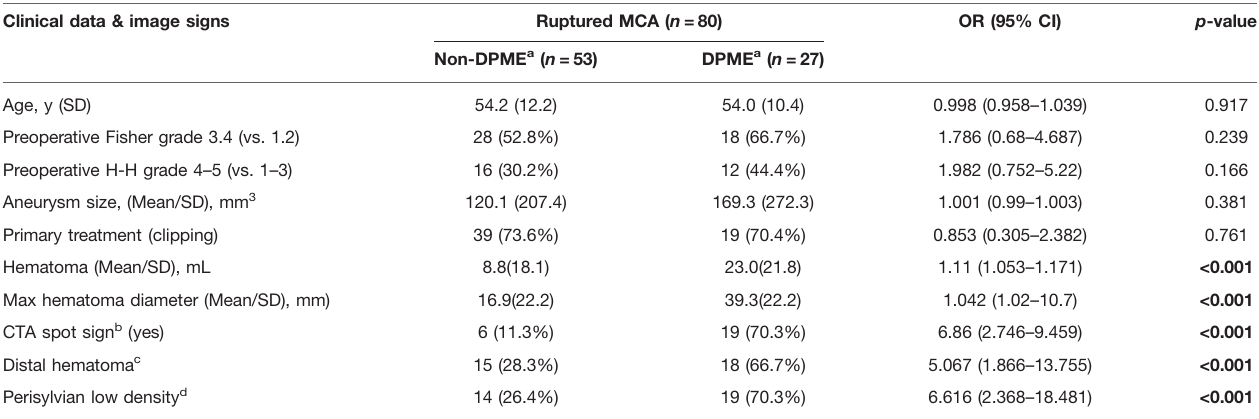
TABLE 3 | DPME predictors after aSAH caused by ruptured MCA aneurysm. Clinical data & image signs